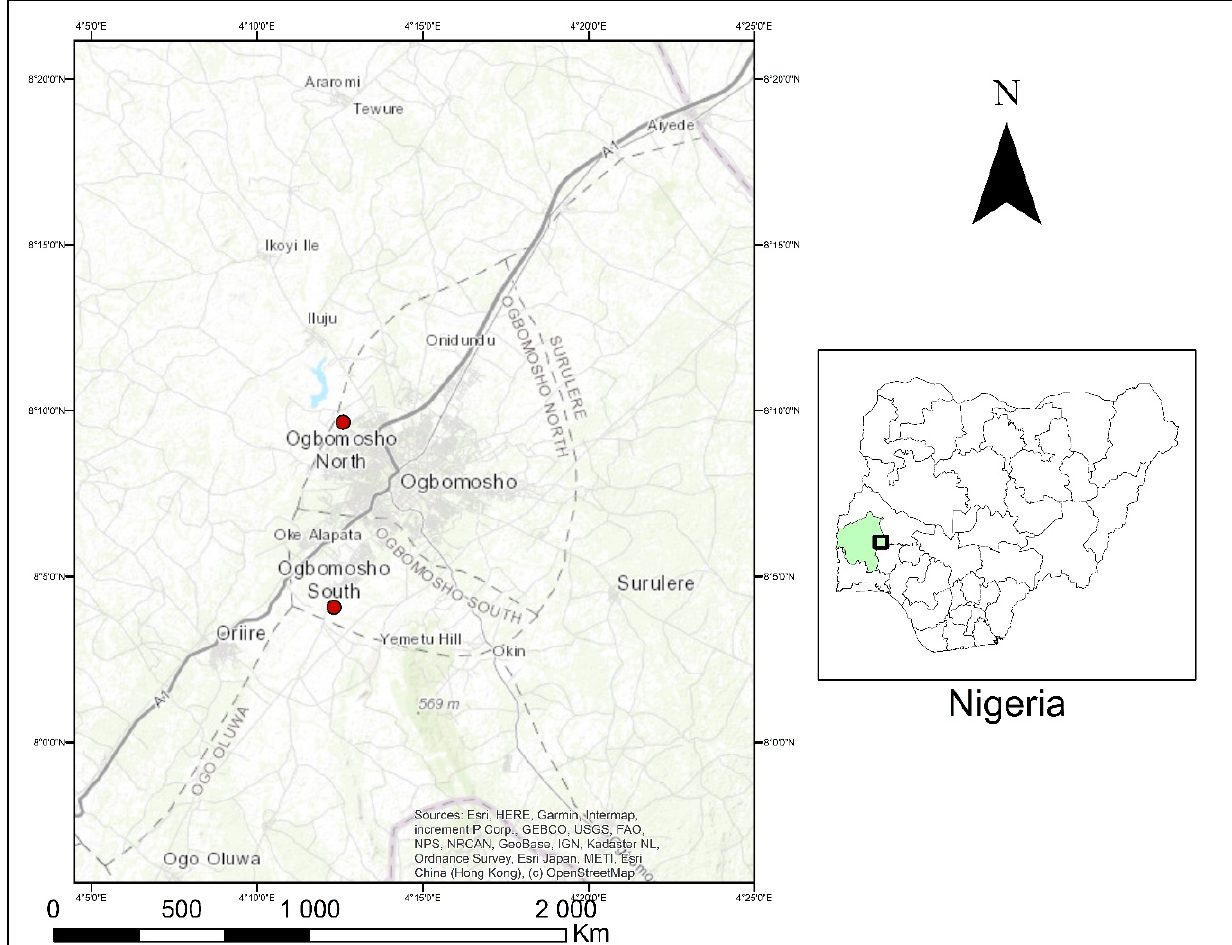
Figure 1. Ogbomosho North and South Local Government Areas, Oyo State, Nigeria.